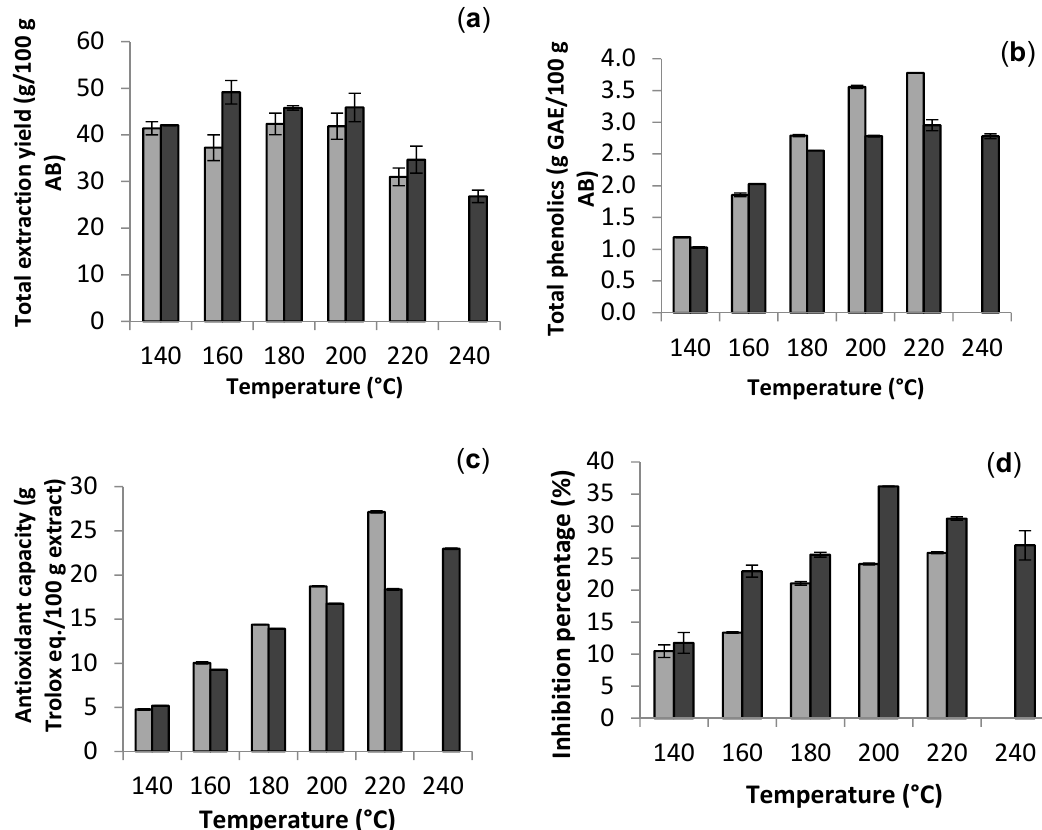
Figure 2. Comparison between autohydrolysis with conventional heating (dark gray) and microwave heating (light gray) on the extraction yield of ( a ) total solubles, ( b ) total phenolics, ( c ) ABTS radical scavenging capacity, and ( d ) DPPH inhibition percentage of the extracts.